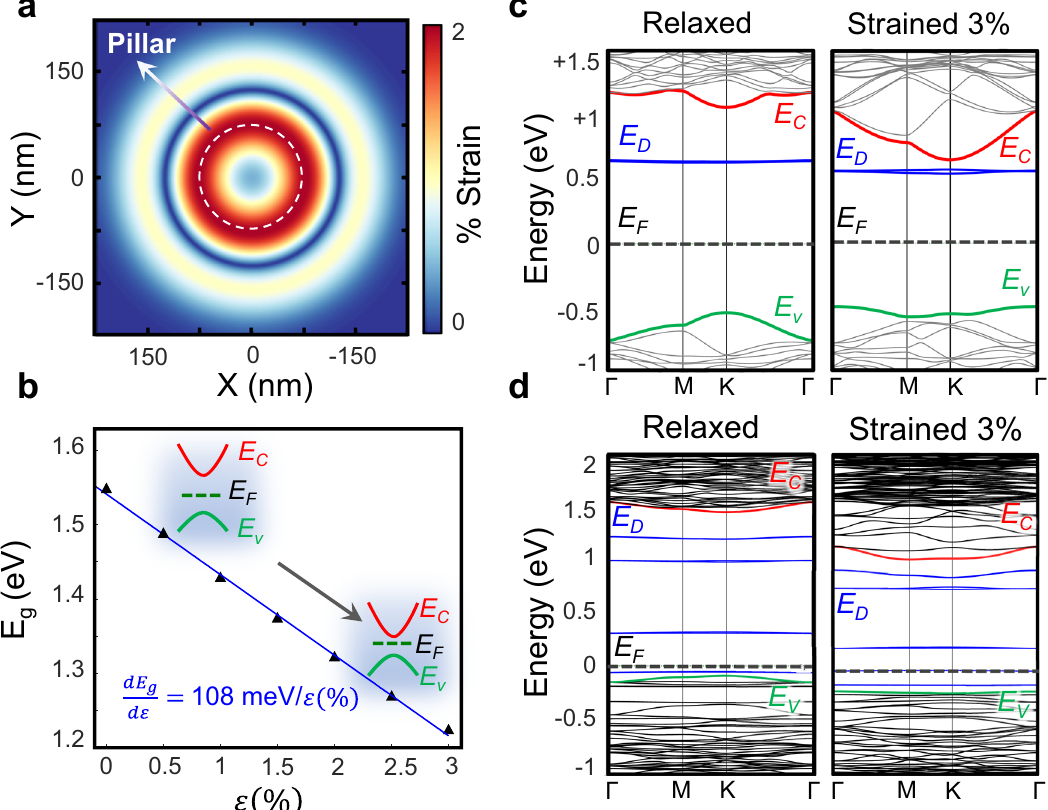
Fig. 6 DFT Calculations of strained defect bandstructure. a Simulated strain pro fi le at the nanopillar location. b Bandgap as a function of applied biaxial tensile strain. The inset band diagram denotes the qualitative movements of conduction band ( E C ), Valence band ( E V ), and the Fermi-level ( E F ) with strain. Note that the conduction band movement is larger with respect to the valence band. c Evolution of the band diagram of selenium vacancy with strain. E D and respective blue bands denote the localized defect levels. Upon the application of strain, E c and E D come into proximity. d Evolution of the band diagram of WSe 6 pore complex vs. strain. After the application of strain, the energy spacing between the conduction band and its closest defect-level decreases. Note that the Fermi-level energy position depends on the size of the